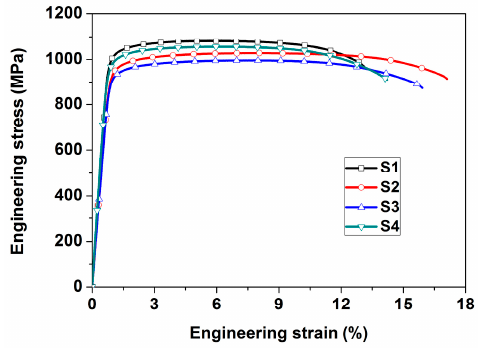
Figure 5. Engineering stress-strain curves of TA15 alloy under different heat treatment routes. Table 3. Tensile properties of TA15 alloy samples.